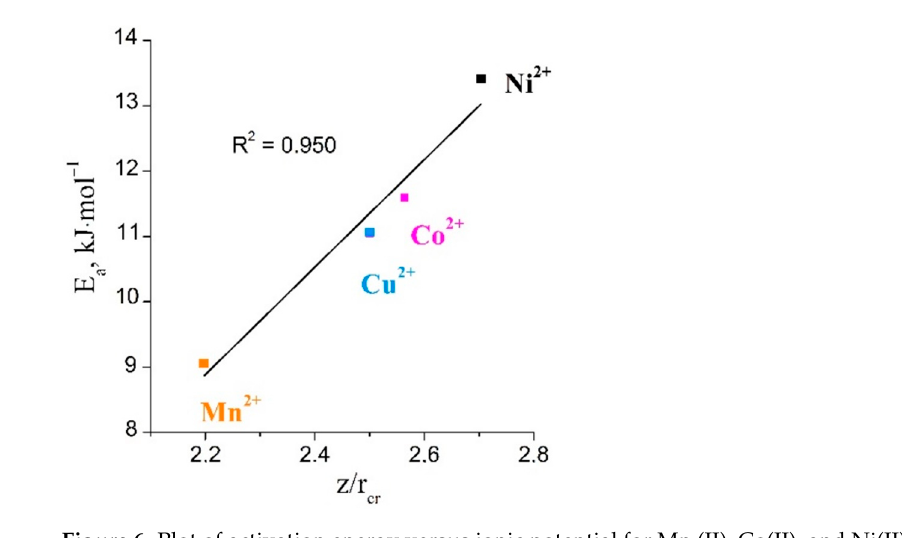
Figure 6. Plot of activation energy versus ionic potential for Mn (II), Co(II), and Ni(II) ions. The calculated D i values for С u 2+ and Cr 3+ were found to be higher than those for Mn 2+ , Co 2+ , and Ni 2+ . We expected that the diffusion coefficient would be lowest for Cr 3+